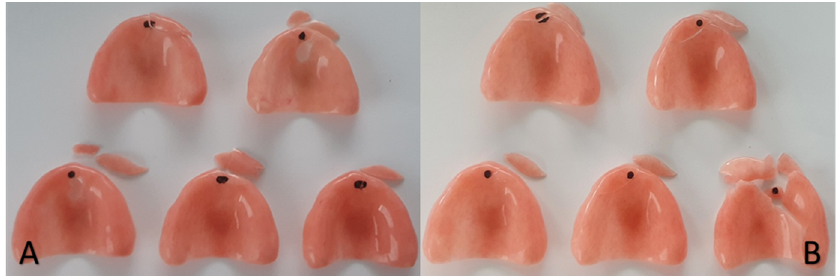
Figure 9. Lucitone HIPA ® ( A ) and Lucitone 199 ® ( B ).